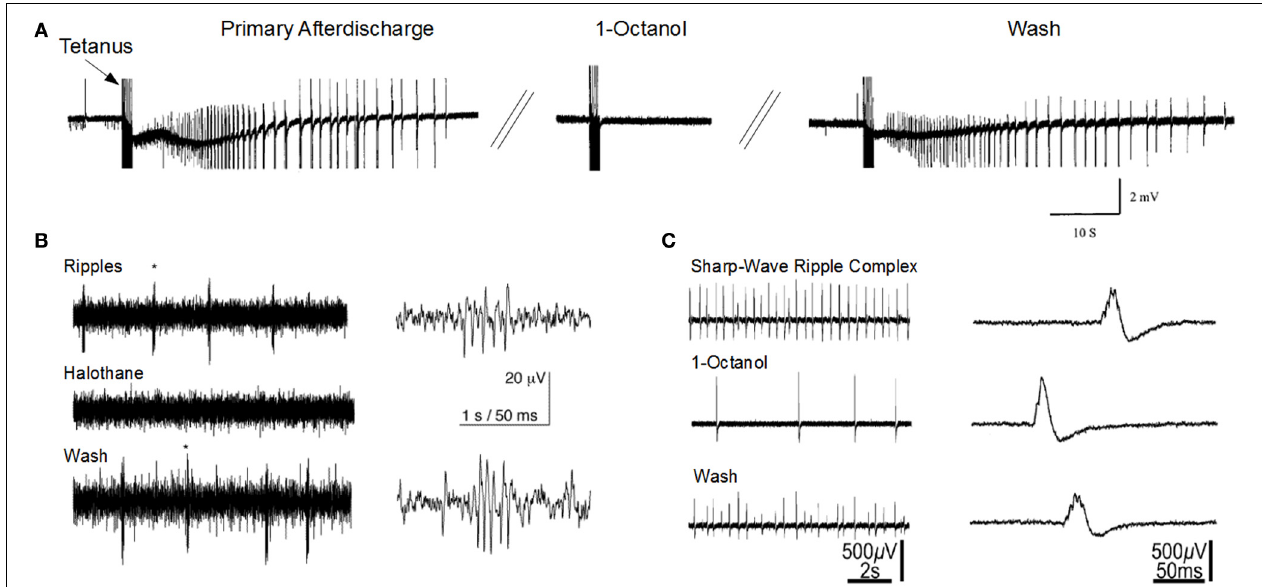
FIGURE 1 | Gap junction blockers inhibit seizure-like activity and sharp-wave ripple activity in the CA1 hippocampal slice. (A) 1-Octanol abolishes primary afterdischarge induced after repeated tetanic stimulation for 2s at 100Hz (Modified with permission from Jahromi et al., 2002). (B) Halothane abolishes high-frequency ripple